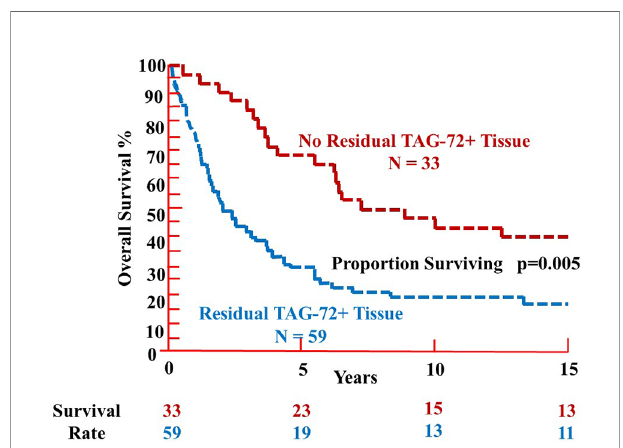
FIGURE 4 | Overall survival of patients with colorectal carcinoma following TAG-72 antigen-directed cancer surgery. Ninety-two primary colorectal carcinoma patients were injected with either murine monoclonal antibody (mMoAb) 125 I-CC49 or mMoAb 125 I-CC83 (16). There was a signi fi cant difference (p = 0.005) in the proportion surviving between those patients with no residual TAG-72-positive tissue at the end of surgery (red dashed line) as compared to those patients where residual TAG-72-positive tissue (blue dashed line) remained at the end of surgery. The survival rate at 5 years was 70% for those patients without residual tumor (upper red values) as compared to 32% for patients with residual TAG-positive tissue (lower blue values). However, there is no signi fi cant difference in the survival rate after 10 and 15 years of